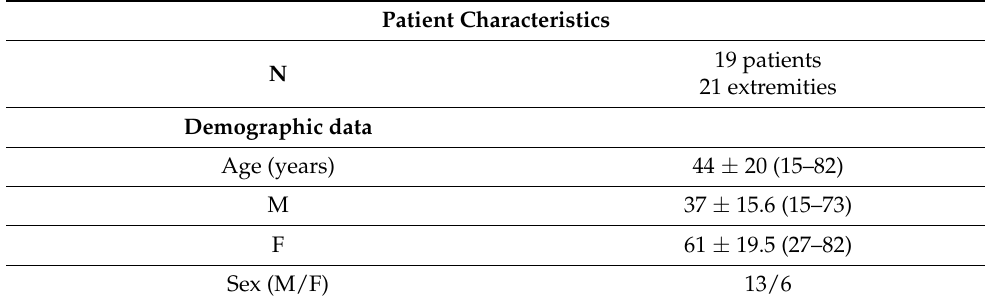
Table 1. Patient characteristics, mean ± SD (range); M, male; F, female; TSF, Taylor Spatial Frame; MVA, motor vehicle accident; tib–fib,